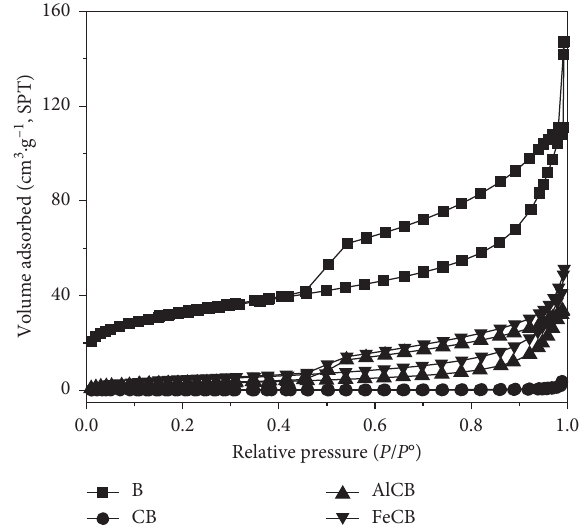
Figure 6: N 2 adsorption-desorption isotherms of B CB, AlCB, and